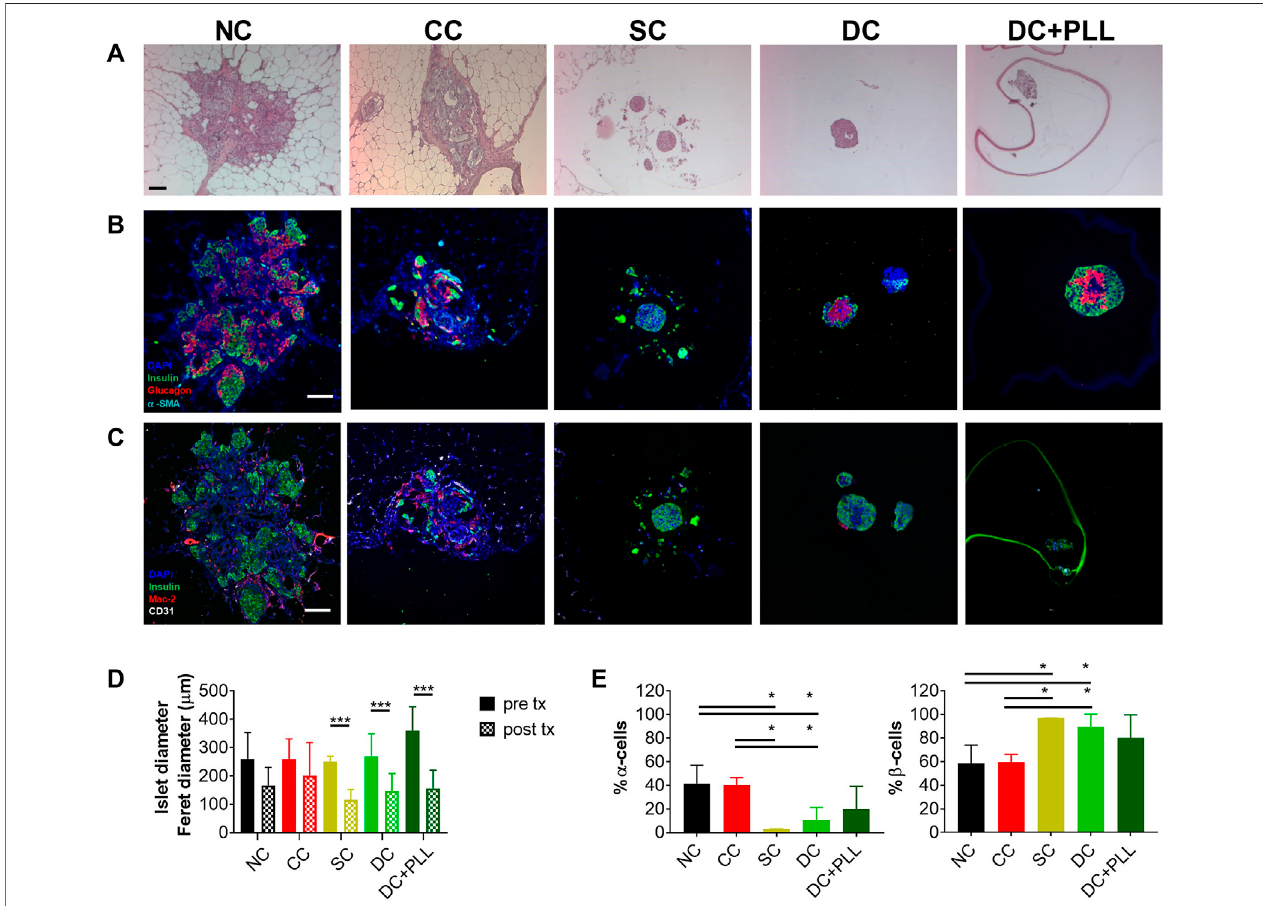
FIGURE 5 | Histological analysis of HI grafts in diabetic NOD-scid mice. Non-coated human islets (NC HIs) and HIs encapsulated through conformal coating (CC), single capsules (SCs), and double capsules with and without PLL (DC + PLL, DCs) were retrieved from the fat pad (NC, CC) or the intraperitoneal cavity (SCs, DCs) of NOD-scid mice 31 days after transplantation. (A – C) Representative images of 10x H&E staining (A) and ×20 immuno fl uorescence staining with antibodies against humaninsulin(green),glucagon(red),andalpha-smoothmuscleactin(cyan) (B) oragainstinsulin(green),Mac-2(red),andCD31(white) (C) . (D – E) Quanti fi cationof HIsizepre-andpost-retrievalfromthefatpad(NC:black,CC:red)andfromtheintraperitonealcavity(SC:yellow,DC-PLL:lightgreen,DC+PLL:darkgreen) (D) andof α - and β -cell fractions (E) . Data are average ±SD for n = 20 islets from three different preparations.